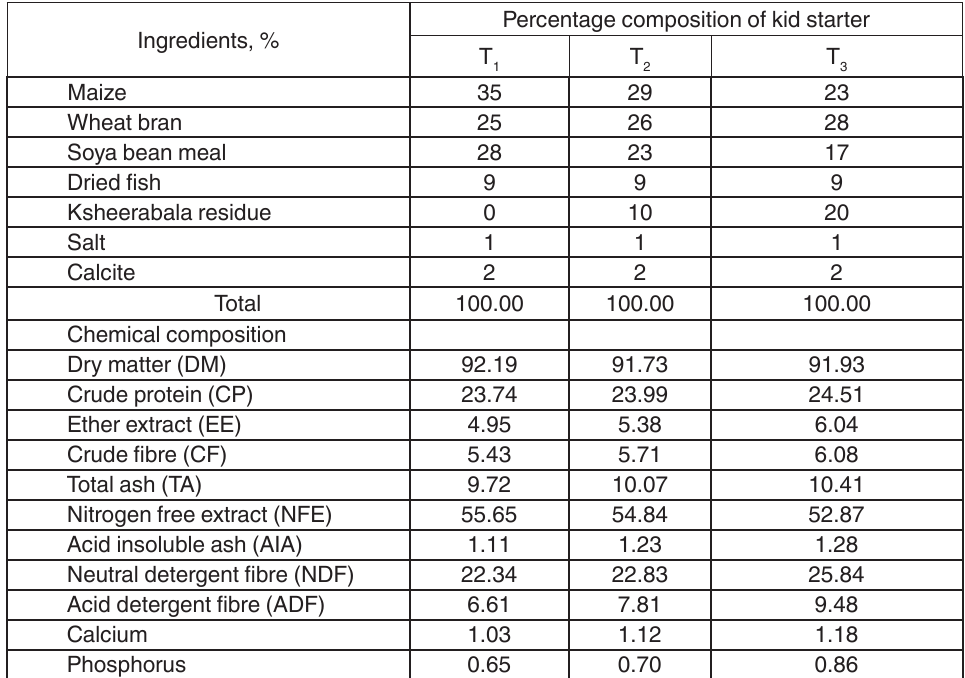
Table 2. Ingredient and chemical composition of kid starters, with dietary incorporation of ksheerabala residue at different levels